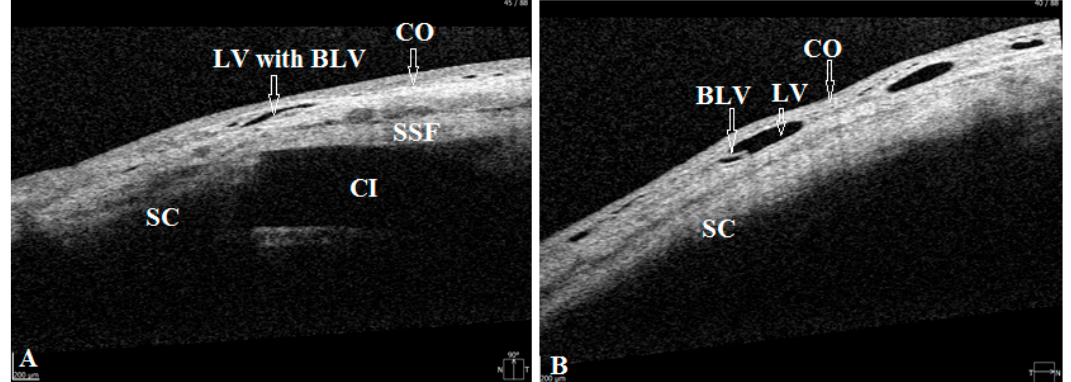
Figure 3. OCT evaluation of surgery and adjunct sites. ( A ) OCT scan of surgery site, showing intras- cleral reservoir with collagen implant (CI), covered by superficial scleral flap (SSF) and conjunctiva (CO). No filtration bleb cavity or subepithelial microcysts are seen over the implant and in the nearby area. A lymphatic vessel (LV) with bicuspid lymphatic valves (BLV) in its lumen (white arrows) is seen running horizontally over the surgery site. ( B ) OCT scan of conjunctiva adjacent to surgery site showing a lymphatic vessel with characteristic bicuspid valve. SC = sclera.